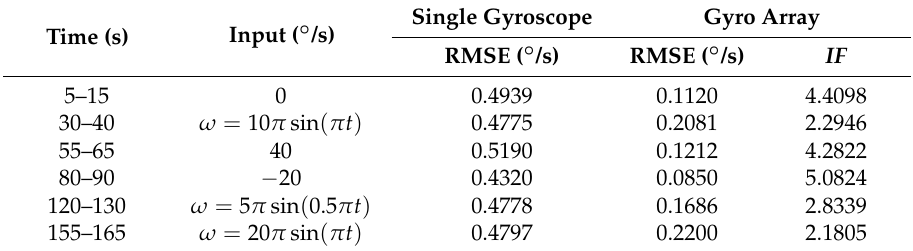
Table 4. The test results over different time periods (different